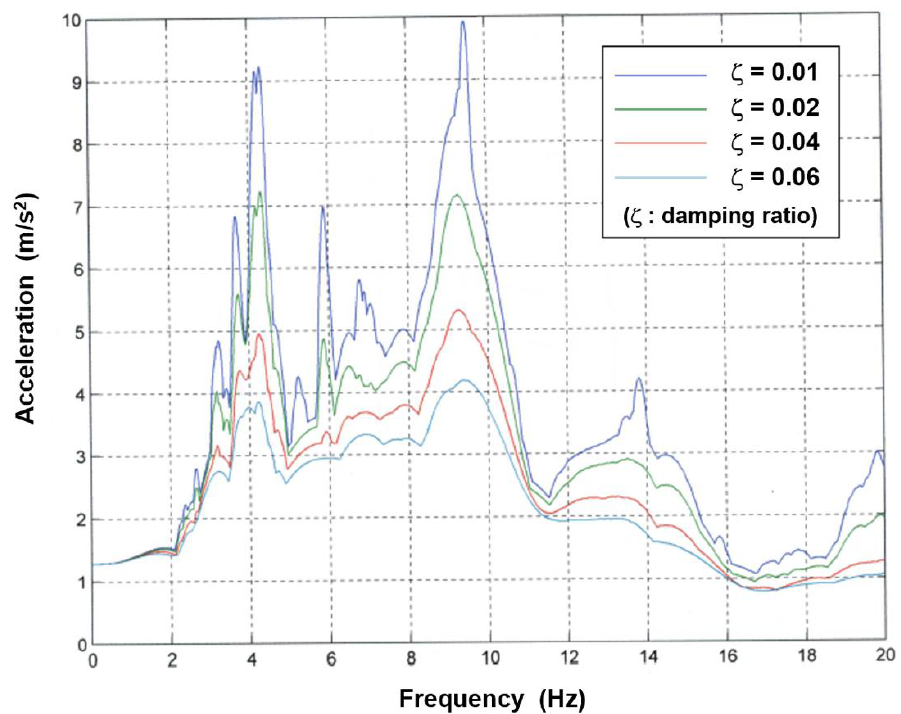
Figure 21. Acceleration-response spectrum to the seismic signal.